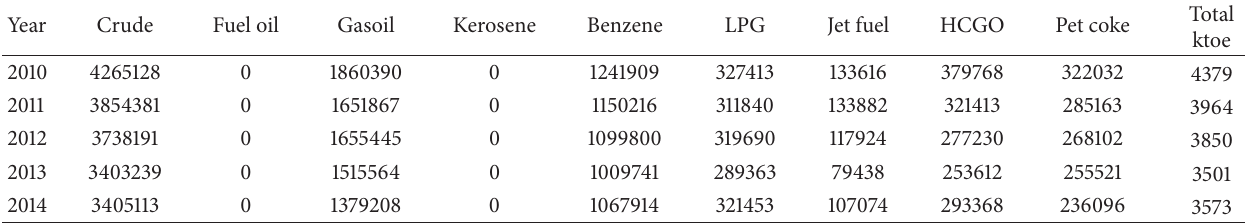
Table 12: KRC products (ton/year) [6].